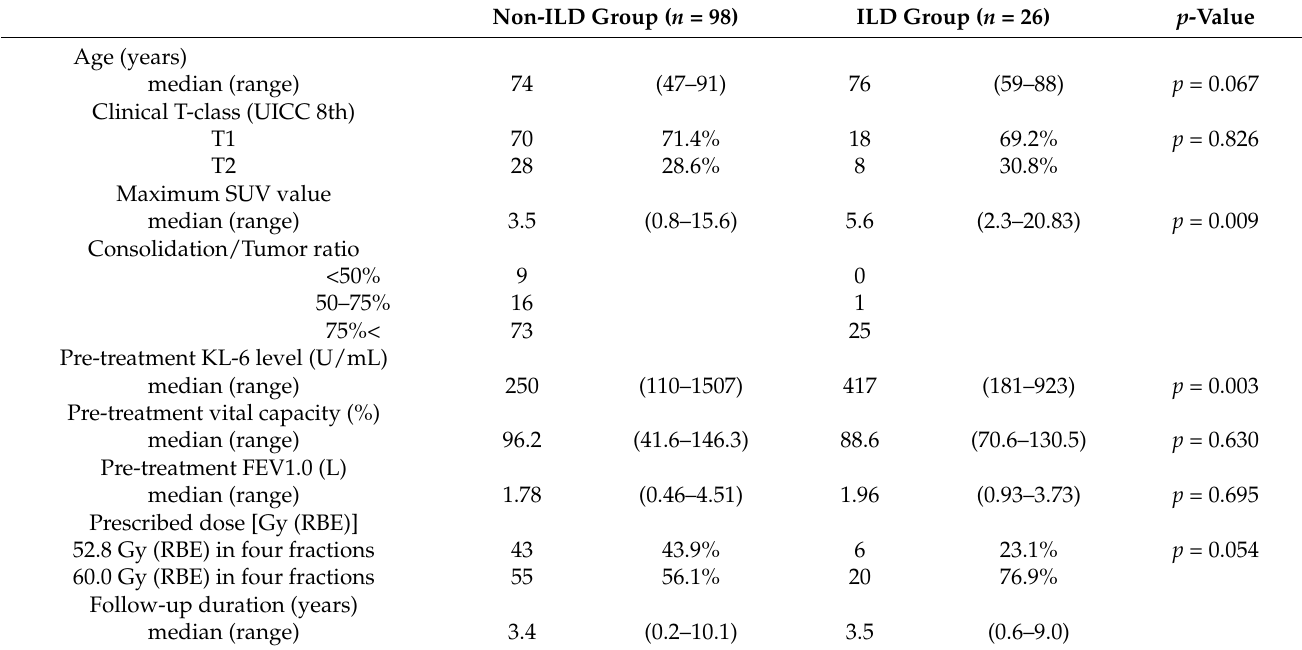
Table 1. Patient